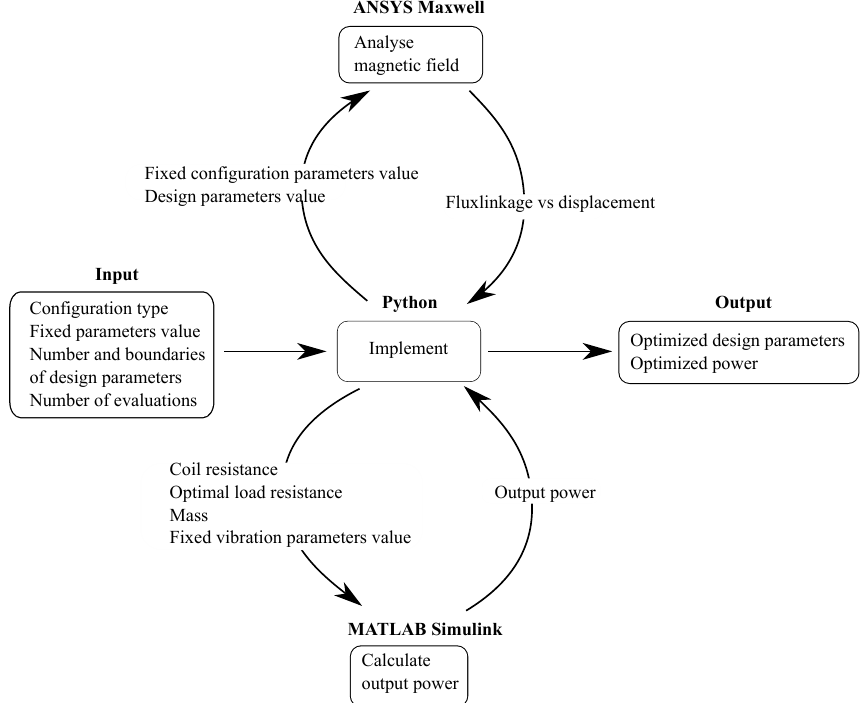
Figure 7. Interaction diagram between the different tools of the multi-tool optimization process. ANSYS Maxwell and MATLAB Simulink are called directly from the Python environment, and thus the user only interacts with